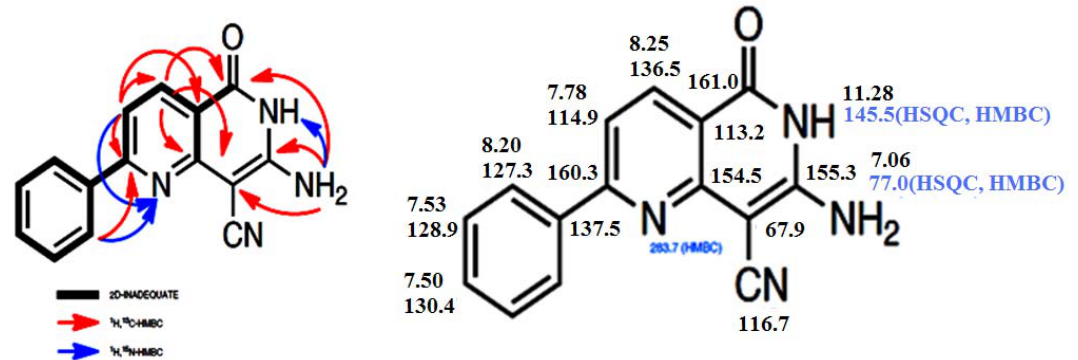
Figure 1. Upper part: ( 13 C, 1 H)- and ( 15 N, 1 H) couplings nJ (n = 2–4) according to the crosspeaks observed in the HMBC measurements of 9c . Lower part: Assignment of all 1 H, 13 C and 15 N signals of 9c . The  values obtained in CD SOCD at room temperature are related 3 3 (liquid). The measurements were performed at 14.1 T (600 MHz for 1 to TMS and NH 3